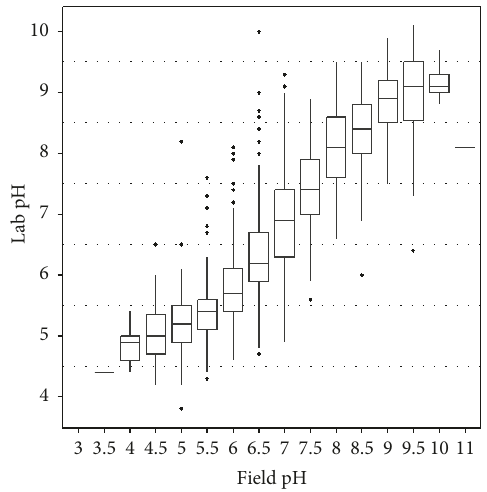
Figure 3: Box plot shows variability in field pH